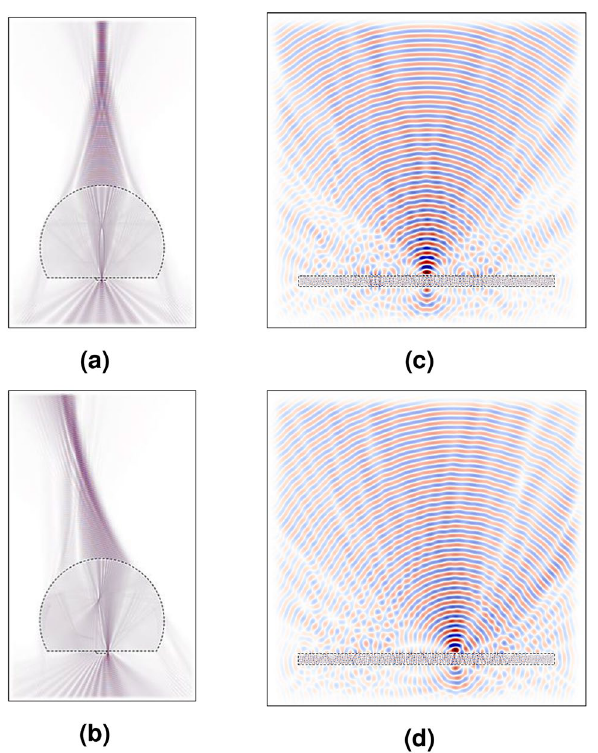
Figure 1. The simulated electric field spread where ( a ) the source is placed at the center of the Si-lens. ( b ) The source is misplaced by 1 mm from the center of the Si-lens. ( c ) The source is placed at the optimal position in the FZP’s center. ( d ) The source is misplaced by 1 mm from the FZP